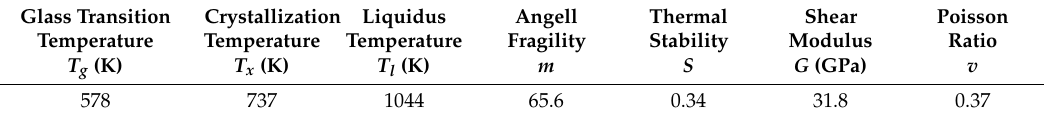
Table 2. Thermal, mechanical, and rheological properties of Zr 35 Ti 30 Cu 8.25 Be 26.75.